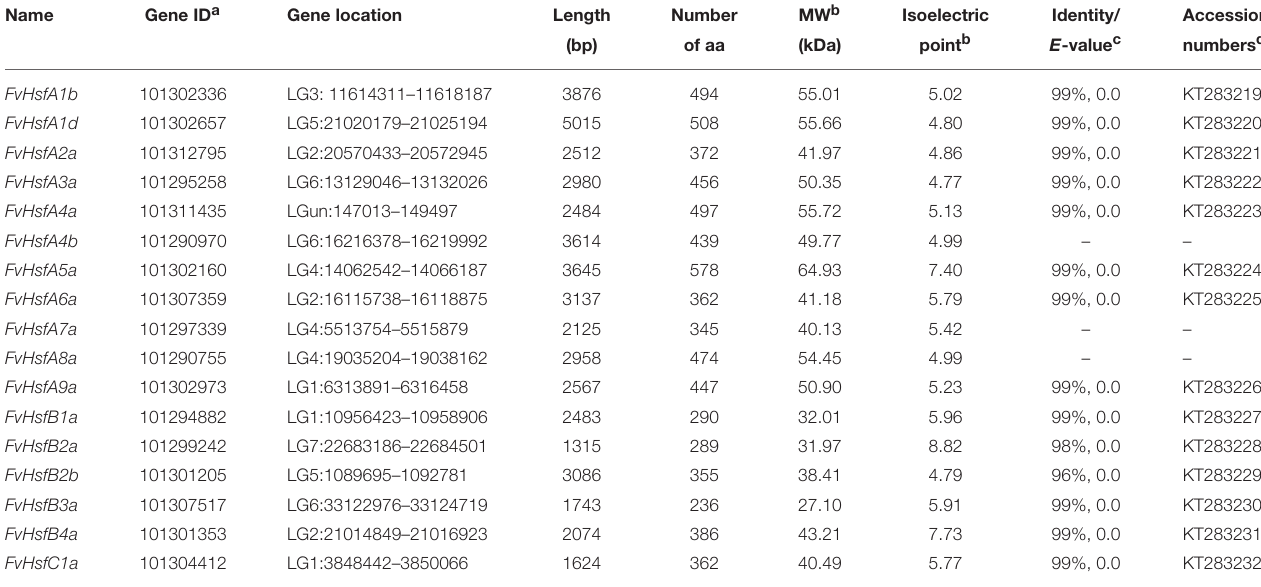
TABLE 1 | Characteristics of strawberry Hsf